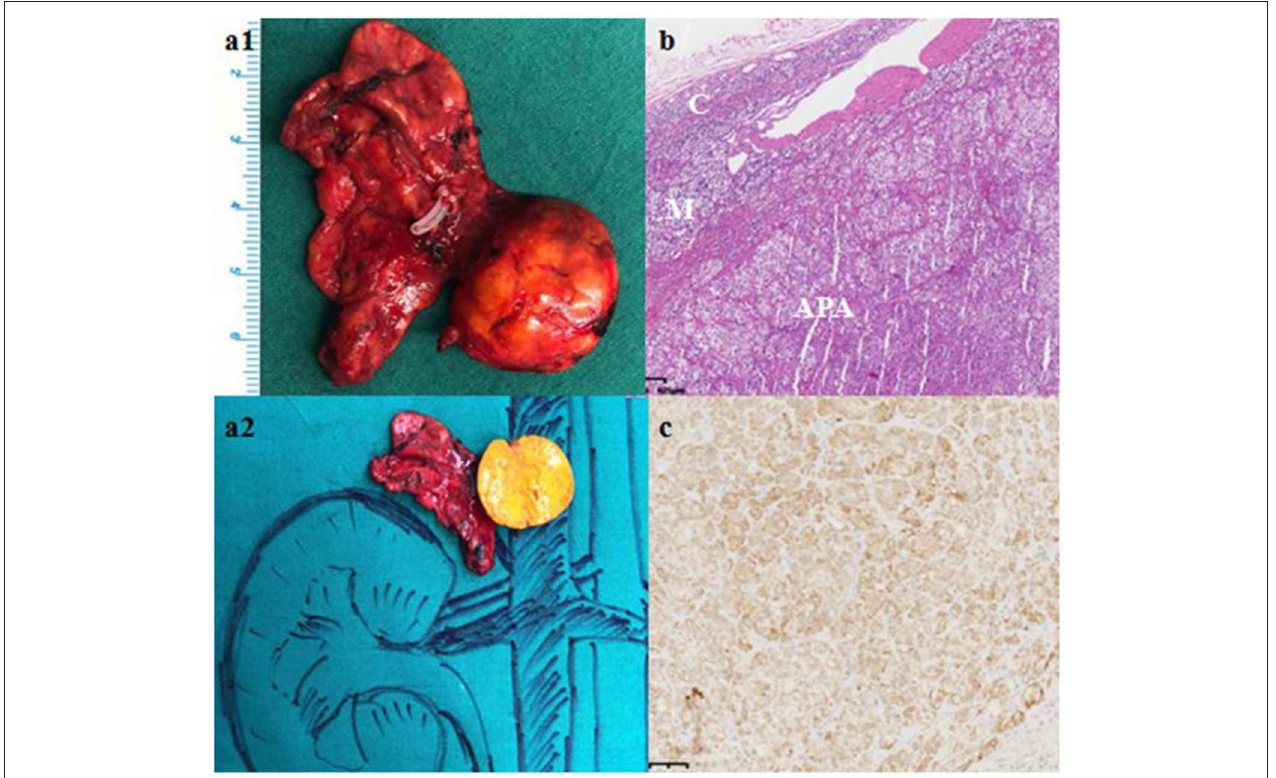
FIGURE 2 | Gross pathological, histological and immunohistochemical findings. (a) Gross pathology revealed a 61 × 27 × 8mm golden-yellow adenoma, which was connected to the right adrenal gland. (b) Hematoxylin-eosin staining, C: Normal adrenal cortex, M: Adrenal medulla; APA: Aldosterone-producing adenoma. (c) Immunohistochemical staining with